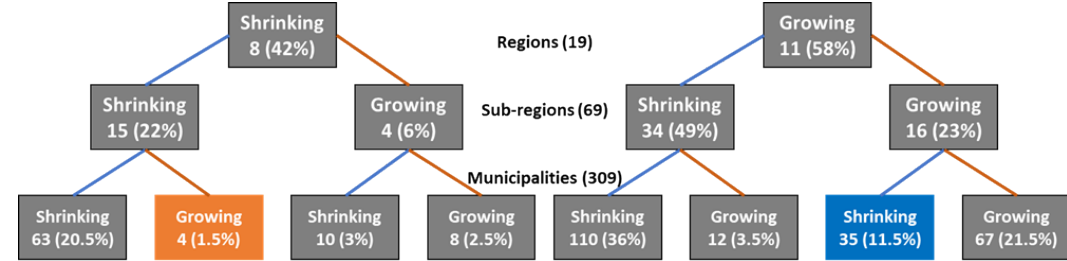
Fig. 11. Number and shares of shrinkage (blue) and growth (orange) pockets in terms of employment